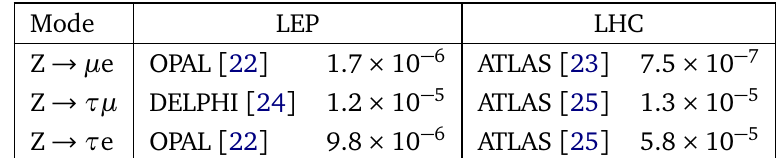
Table 3: Branching fraction limits (95% CL) on charged lepton flavour violation from Z